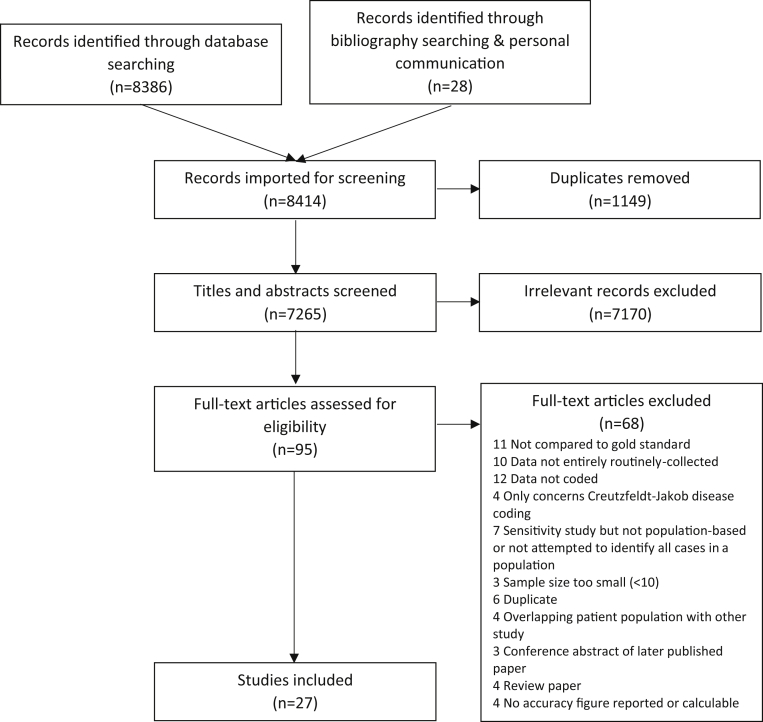
Study selection process.